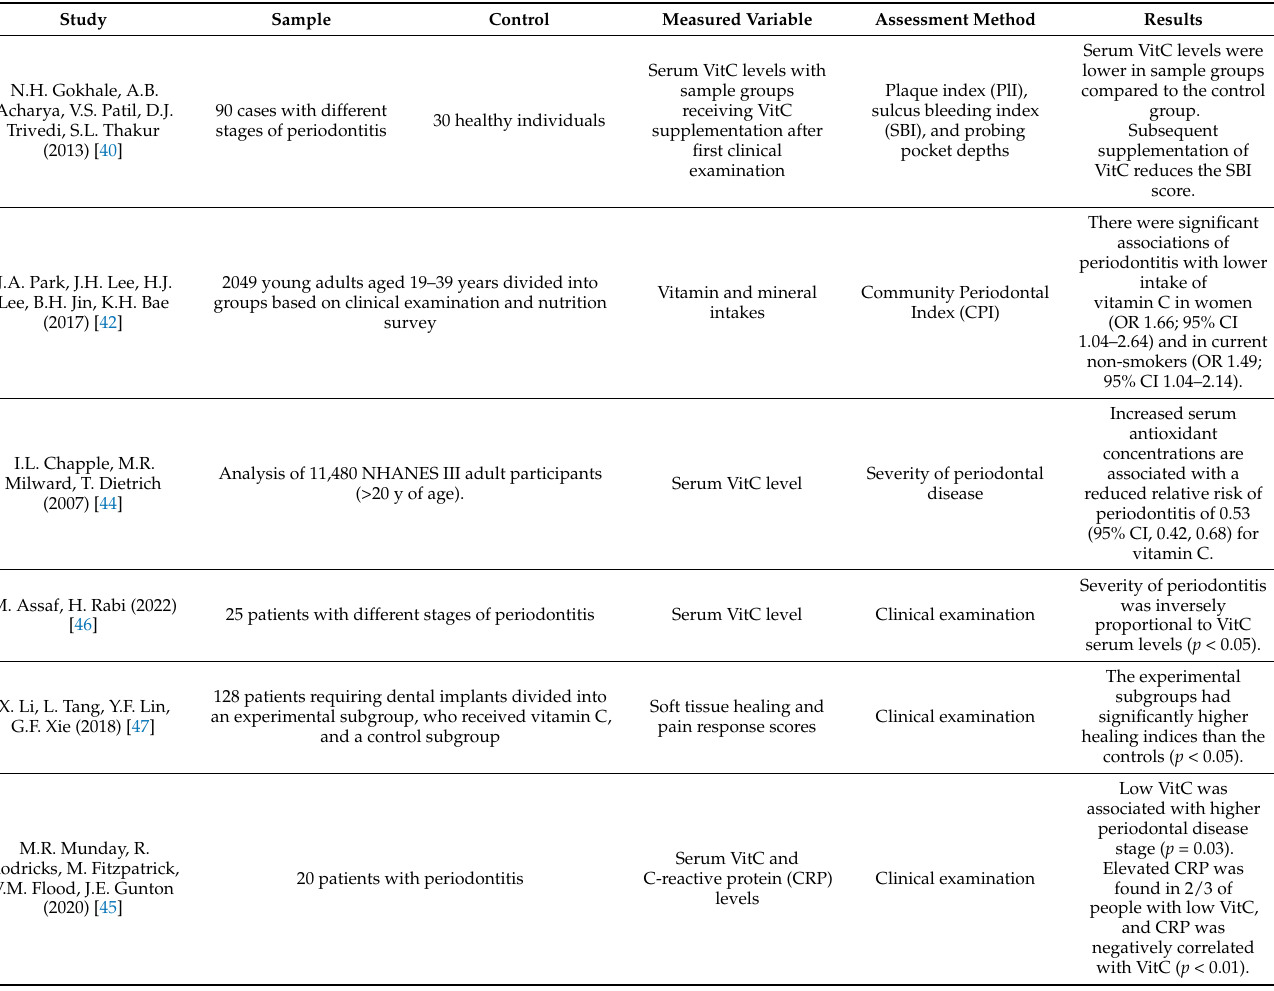
Table 1. A summary of the most important studies on the effects of VitC on periodontal